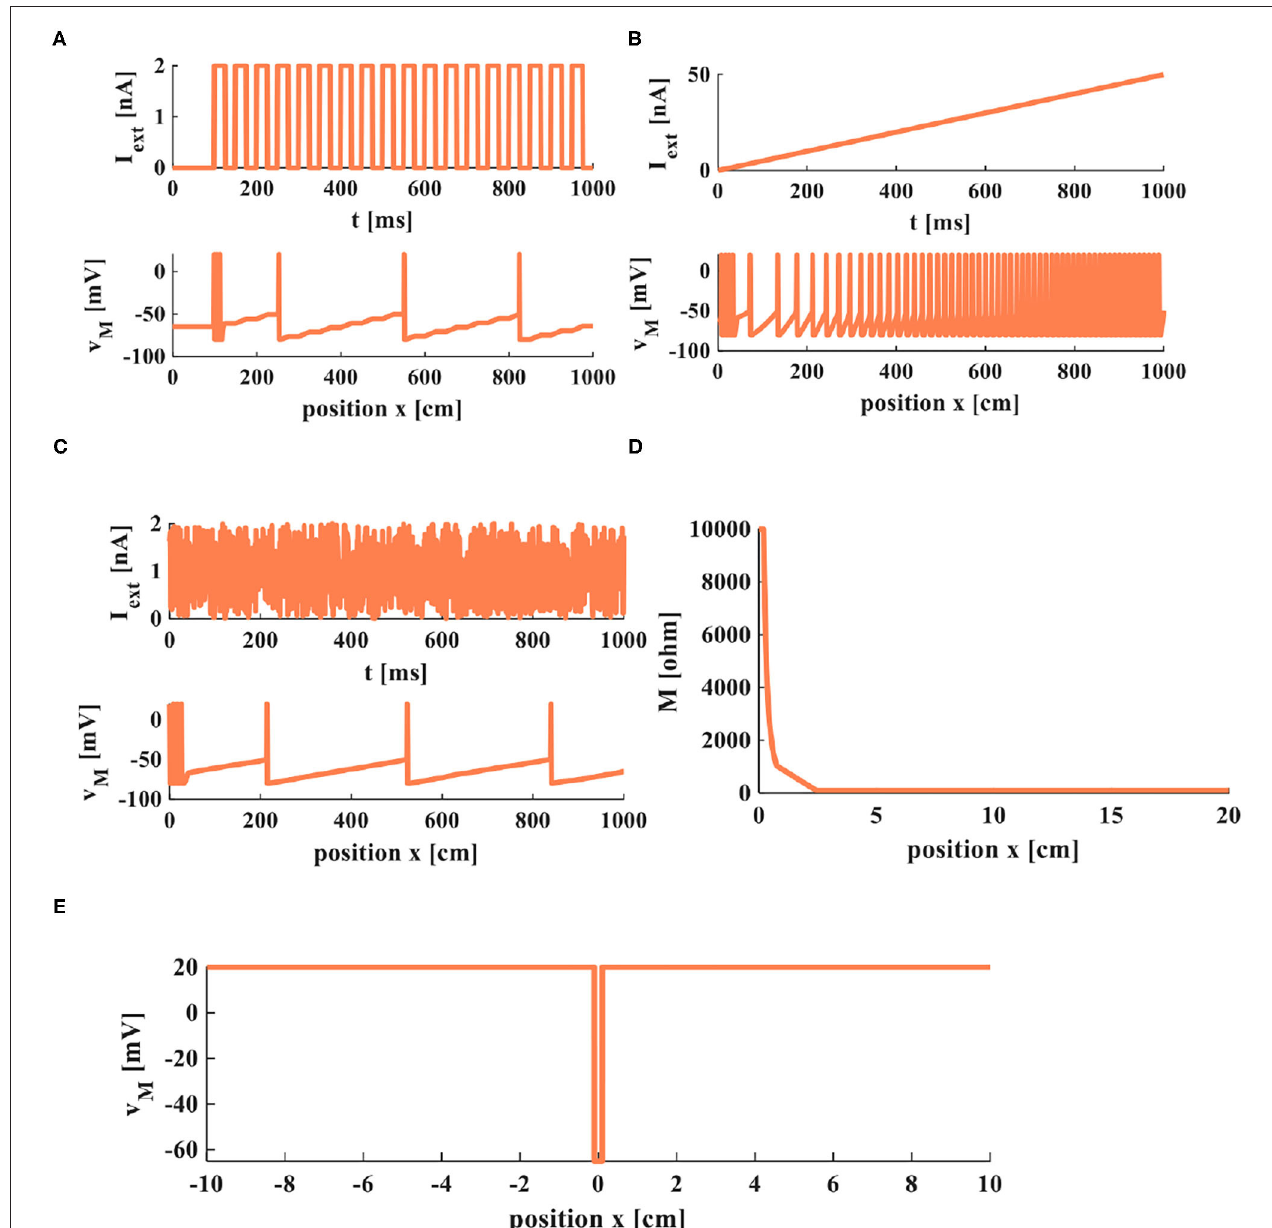
FIGURE 9 | Firing and propagation of electrical signals in a cable axon. (A) A series of pulses applied on the cable axon. (B) The rump current is applied to the cable axon. (C) The noisy input is applied to the cable axon. (D) The relationship between memristor and the position. (E) The relationship between membrane potential and the